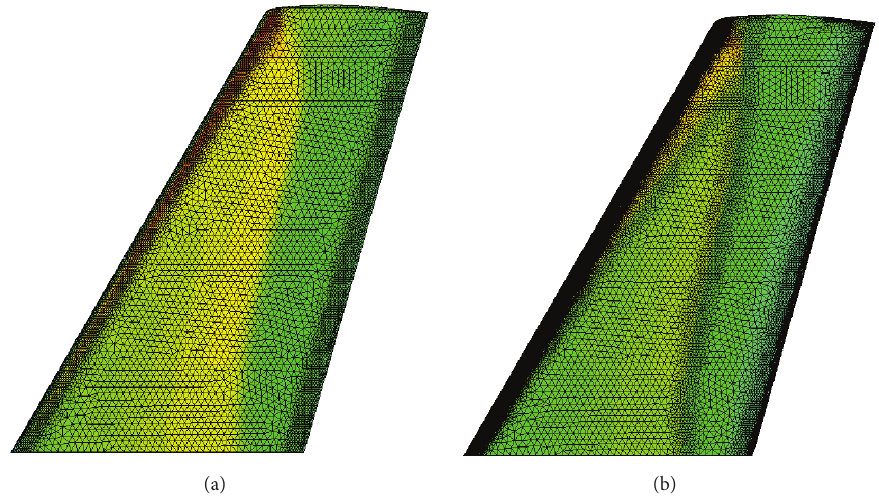
F 11: ONERA M6 wing. Nonadapted grid (a) and adapted grid (b).